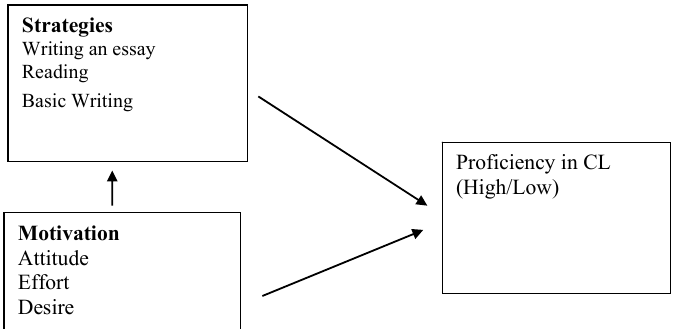
Figure 2. Proficiency in CL: Factors Involved.